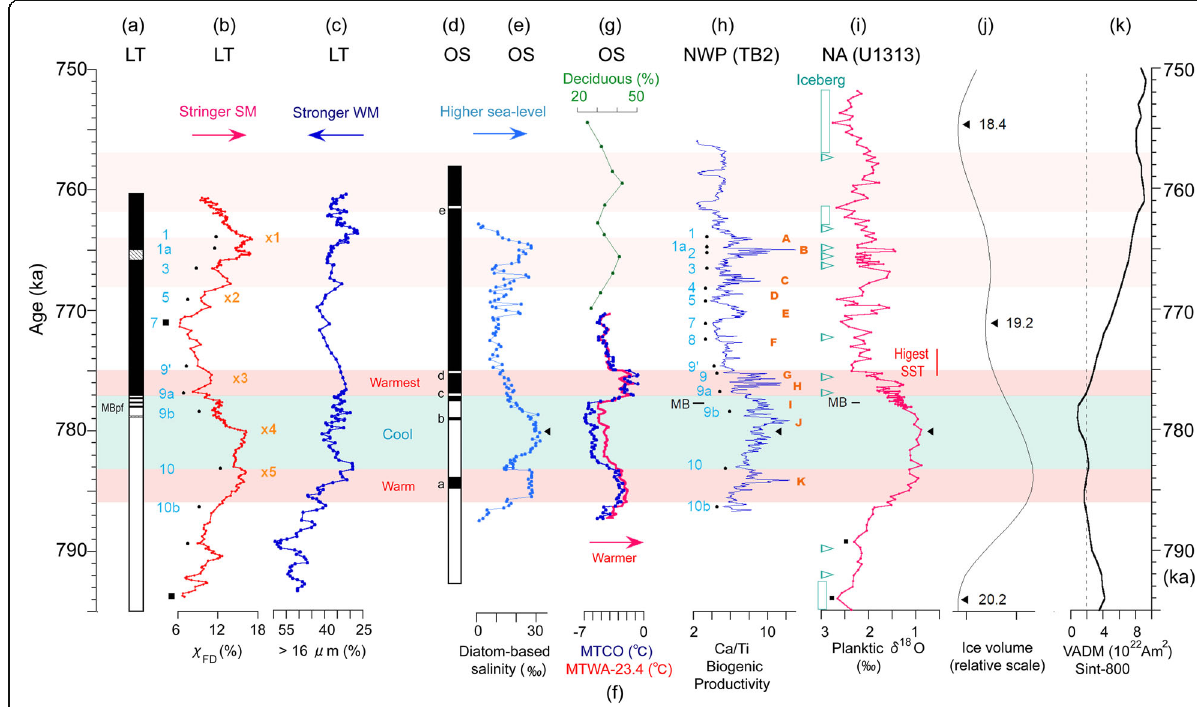
Fig. 6 Comparison of magnetic, climatic and paleoceanic variations. a – c The data of Lingtai. a The magnetic polarity stratigraphy. b The frequency dependence of magnetic susceptibility χ FD (an SM proxy). The dots and squares represent age controls of the cool/low sea-level events and “ x1 – x5 ” show the SM events defined in the Xifeng loess sequence (Ueno et al. 2019). c The coarse grain size (a WM proxy) (Ueno et al. 2019). d – g The data from Osaka Bay. d The magnetic polarity stratigraphy (Hyodo et al. 2006). e Diatom-based salinity (sea-level proxy) (Maegakiuchi et al. 2016). f Mean temperatures of the coldest month (MTCO) and warmest month (MTWA) (Kitaba et al. 2013). g Proportion of deciduous trees (warm proxy) (Hyodo and Kitaba 2015). h The Ca/Ti ratio reflects biogenic productivity in Northwest Pacific based on the Chiba Section core TB2 (Hyodo et al. 2017). The dots designated “ 1 – 10b ” show cool/low sea-level events, and “ A – K ” show warm/high sea-level events. i Planktic δ 18 O from the mid-latitude North Atlantic, with iceberg discharge events and the highest sea surface temperature interval (after Ferretti et al. 2015). The age model is after Hyodo et al. (2017). j Ice-volume model (after Hyodo et al. 2017). k Virtual dipole moment (after Guyodo and Valet 1999). Black/white/hatched areas in the magnetic polarity stratigraphy: normal-polarity/reverse-polarity/excursion. M: Matuyama. B: Brunhes. MBpf: Matuyama-Brunhes polarity flip (see text). “ MB ” in h and i represents the Matuyama – Brunhes boundary. The arrow heads in e , h , and i show the MIS 19.3 sea-level